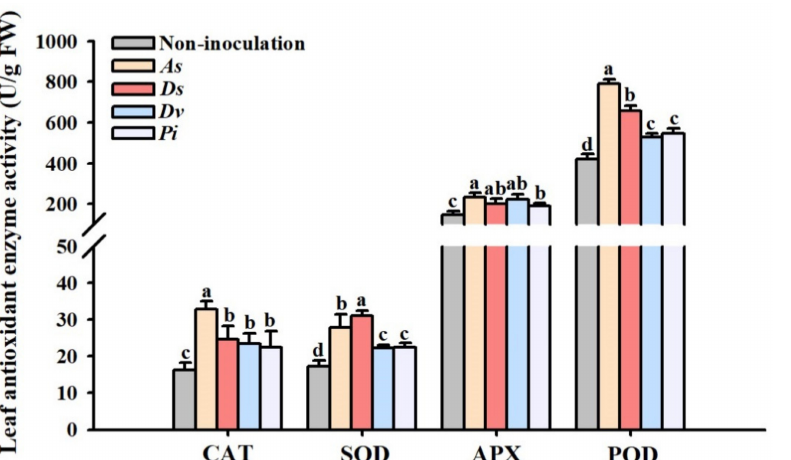
Figure 2. The effect of inoculation with Acaulospora scrobiculata ( As ), Diversispora spurca ( Ds ), D . ver- siformis ( Dv ), and Piriformospora indica ( Pi ) on leaf catalase (CAT), superoxide dismutase (SOD), ascorbate peroxidase (APX), and peroxidase (POD) activity of the lane late navel orange trees. Data (means ± SD, n = 4) are significantly ( p < 0.05) different if followed by different letters above the bars.